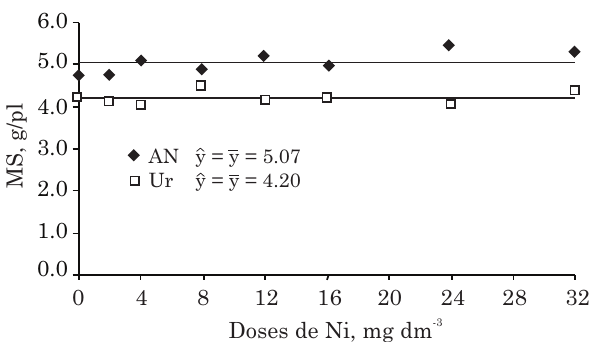
Figure 1. Lettuce dry-matter (DM) shoot production as a function of Ni doses applied to the soil and under plant N supply by additions of ammonium nitrate (AN) and urea (Ur) to the